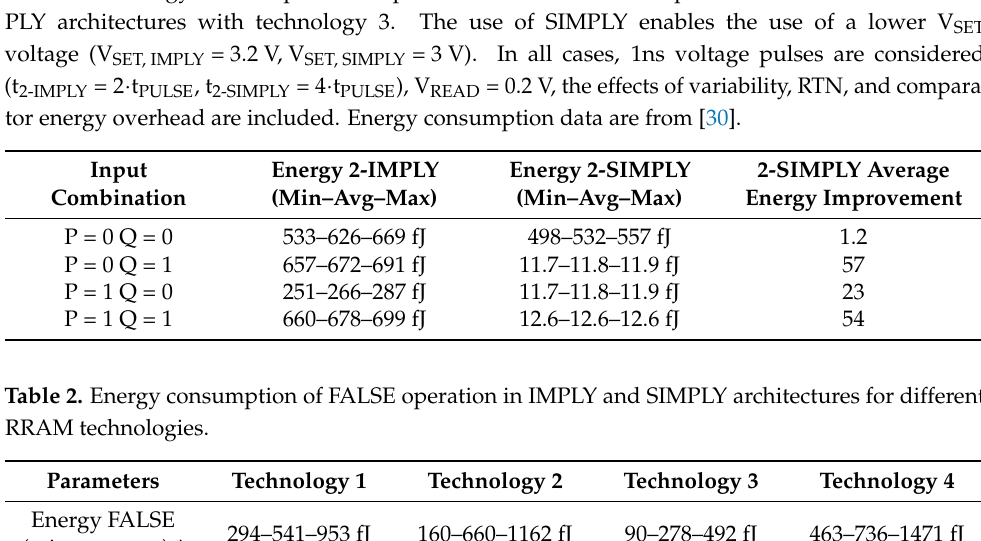
Table 1. Energy consumption comparison of the 2-IMPLY operation in IMPLY and SIMPLY architectures with technology 3. The use of SIMPLY enables the use of a lower V SET voltage (V SET, IMPLY = 3.2 V, V SET, SIMPLY = 3 V). In all cases, 1ns voltage pulses are considered (t 2-IMPLY = 2 ∙ t PULSE , t 2-SIMPLY = 4 ∙ t PULSE ), V READ = 0.2 V, the effects of variability, RTN, and comparator energy overhead are included. Energy consumption data are from [30].